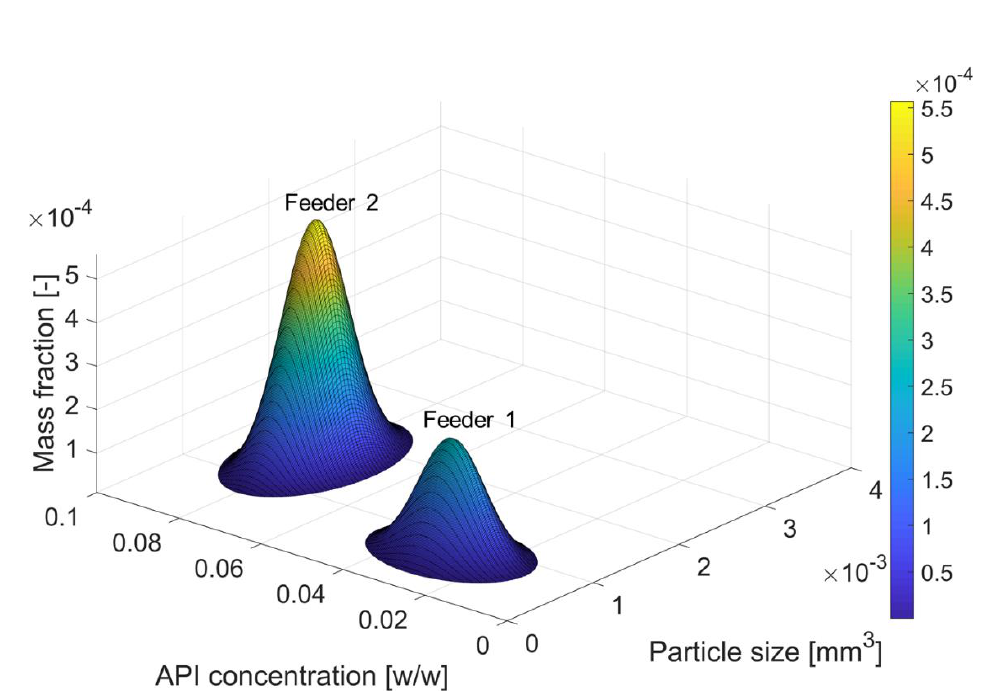
Figure 13. Initial distribution for the coupled agglomeration and breakage process.